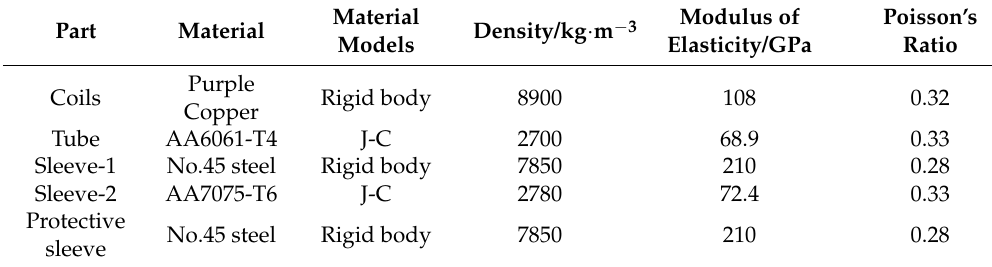
Table 5. Finite element model mechanical properties’ parameter